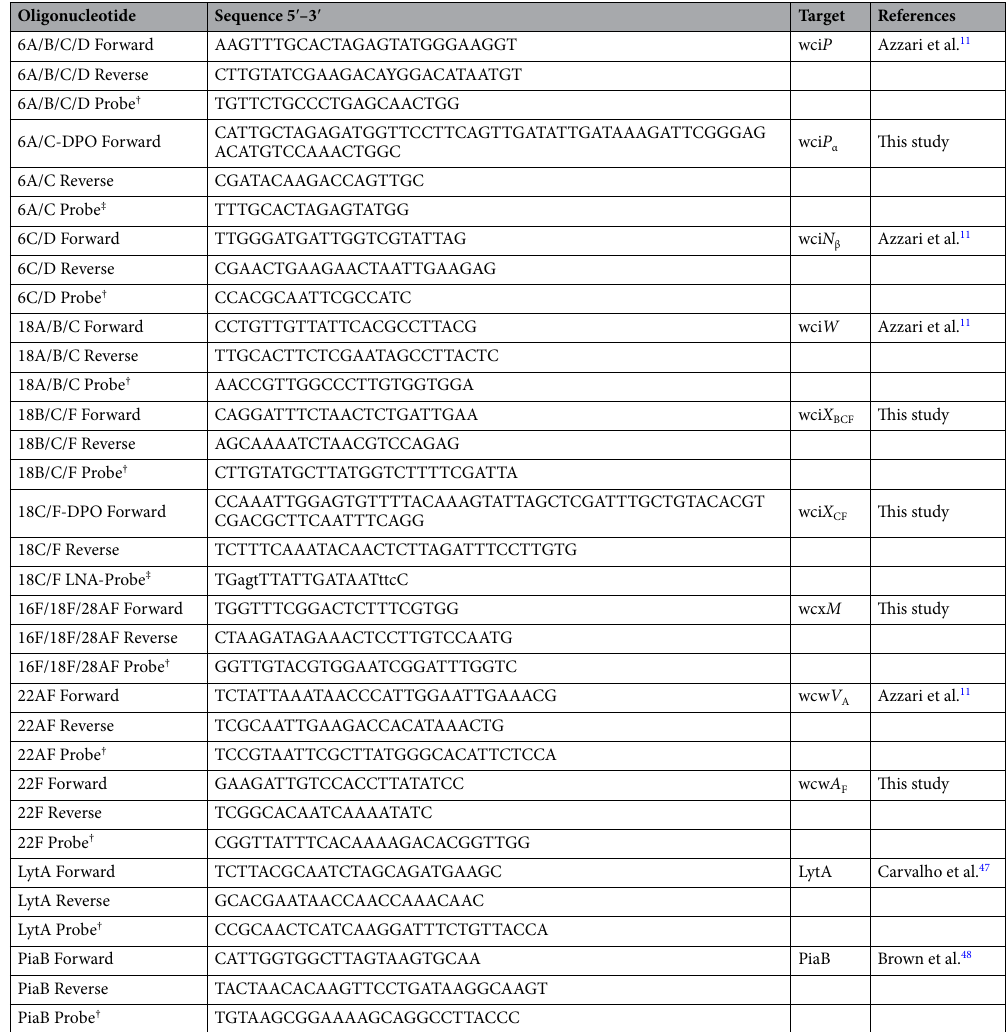
Table 3. Primer and probe assay-sets for serogroup 6, 18 and 22 detection and serotype discrimination. Nucleotides in lower case correspond to locked nucleic acid (LNA) modified bases. † 5 ′ -FAM- NFQ-3 ′ labelled dye (Thermofisher). ‡ 5 ′ 6-FAM- BHQ1-3 ′ labelled dye (Integrated DNA